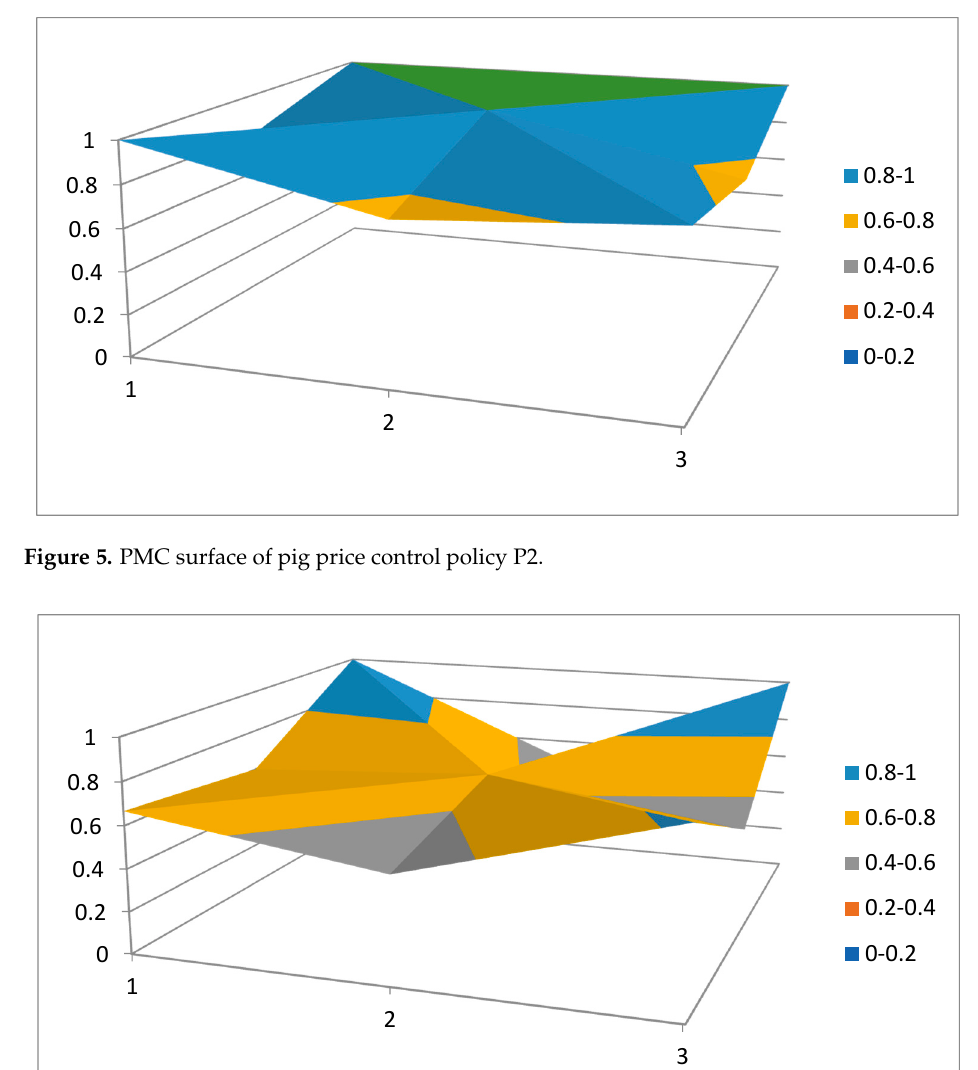
Figure 4. PMC surface of pig price control policy P1.